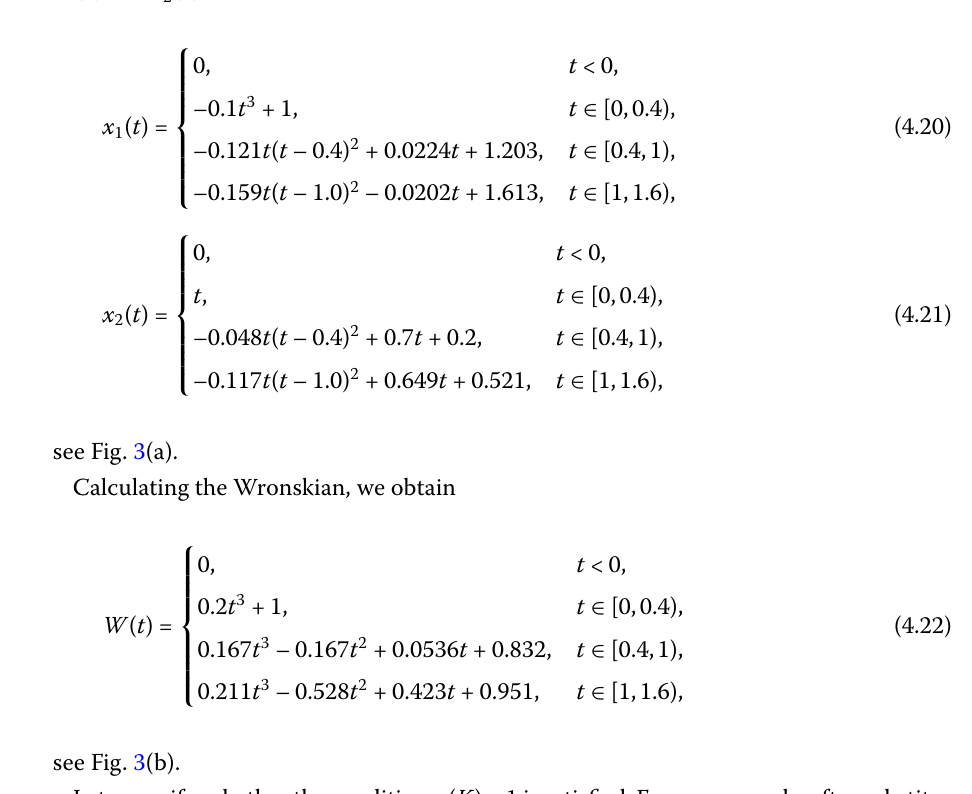
satisfies the inequality C 1 ( t , s ) ≥ 0,